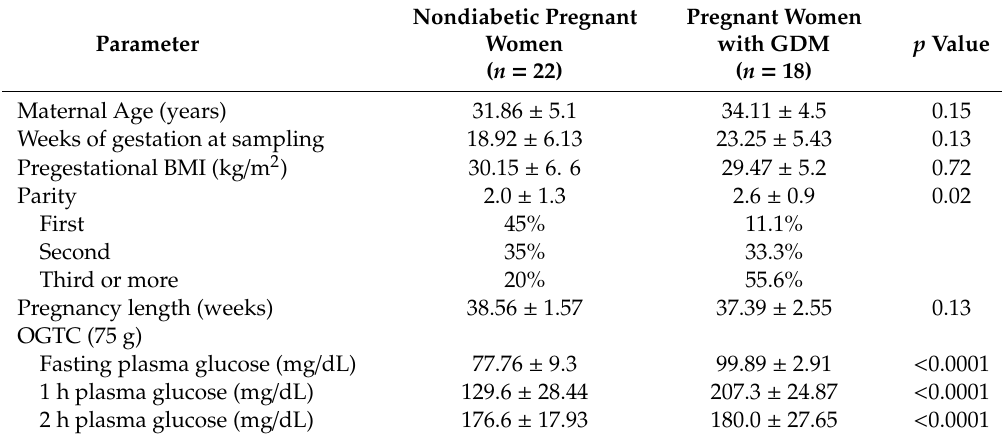
Table 1. Population